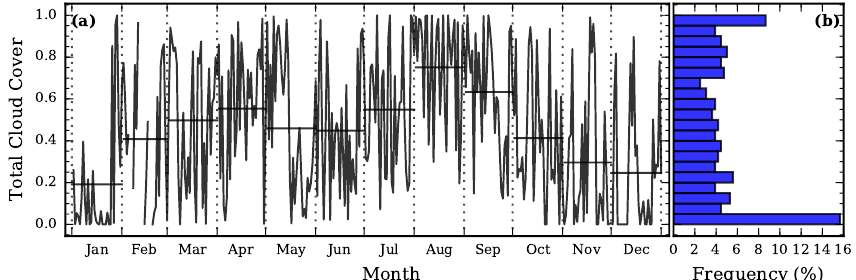
Figure 4. ( a ) European Center for Medium-Range Weather Forecasts (ECMWF) 12 UTC total cloud cover (TCC) variation and ( b ) its frequency histogram in Maroua in 2014. Horizontal segments represent TCC monthly averages, and vertical dashed lines represent month